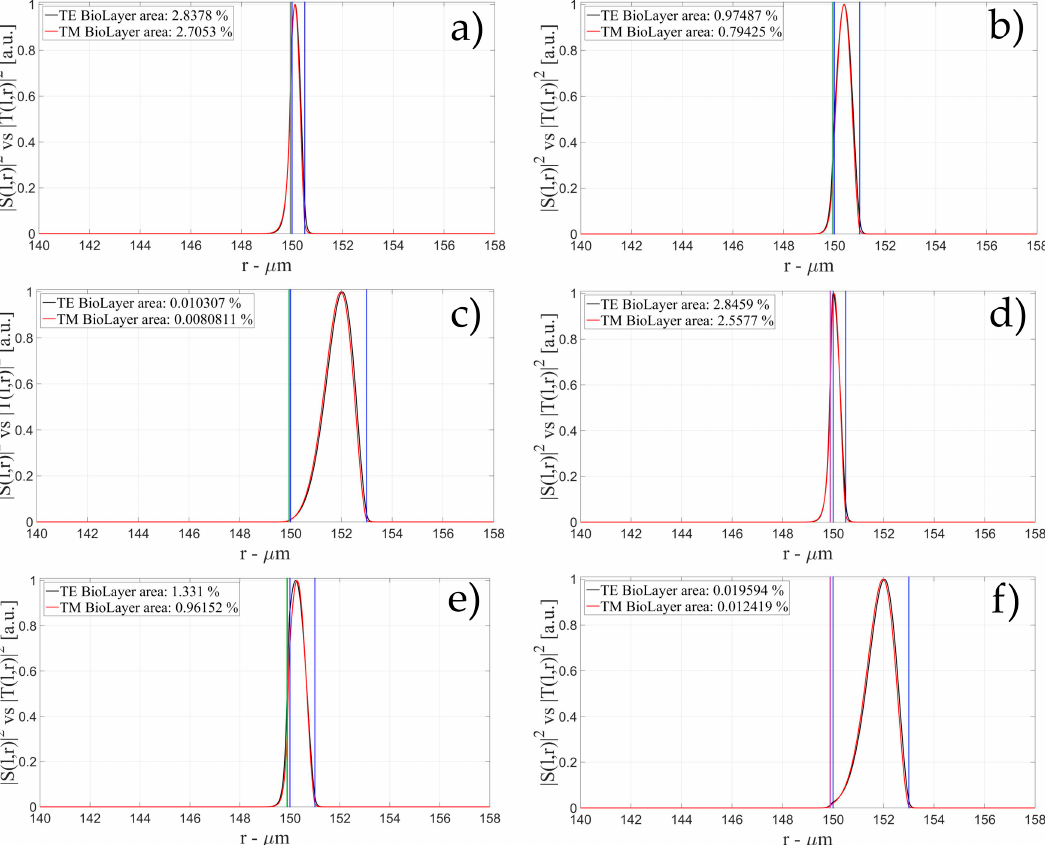
Figure 7. Electric field distribution of WGMs along the radial direction for TE (| S ( l,r ) | 2 ) and TM (| T ( l,r ) | 2 ) modes for the 1st radial order: ( a ) for a wall of about 500 nm and a polymer thickness of about 50 nm; ( b ) for a wall of about 1 μ m and a polymer thickness of about 50 nm and ( c ) for a wall of about 3 μ m and a polymer thickness of about 50 nm; ( d ) for a wall of about 500 nm and a polymer thickness of about 100 nm; ( e ) for a wall of about 1 μ m and a polymer thickness of about 100 nm and ( f ) for a wall of about 3 μ m and a polymer thickness of about 100 nm. Legends show the fraction of | S ( l,r ) | 2 and | T ( l,r ) | 2 inside the biological layer.